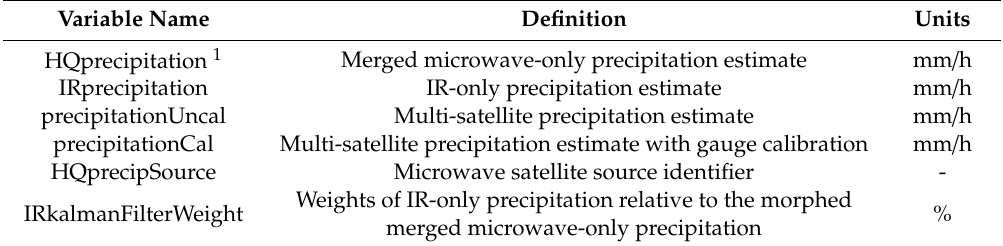
Table 1. List of used variable names, their definition, and units in the Integrated Multi-satellitE Retrievals for the Global Precipitation Measurement mission (IMERG) products.